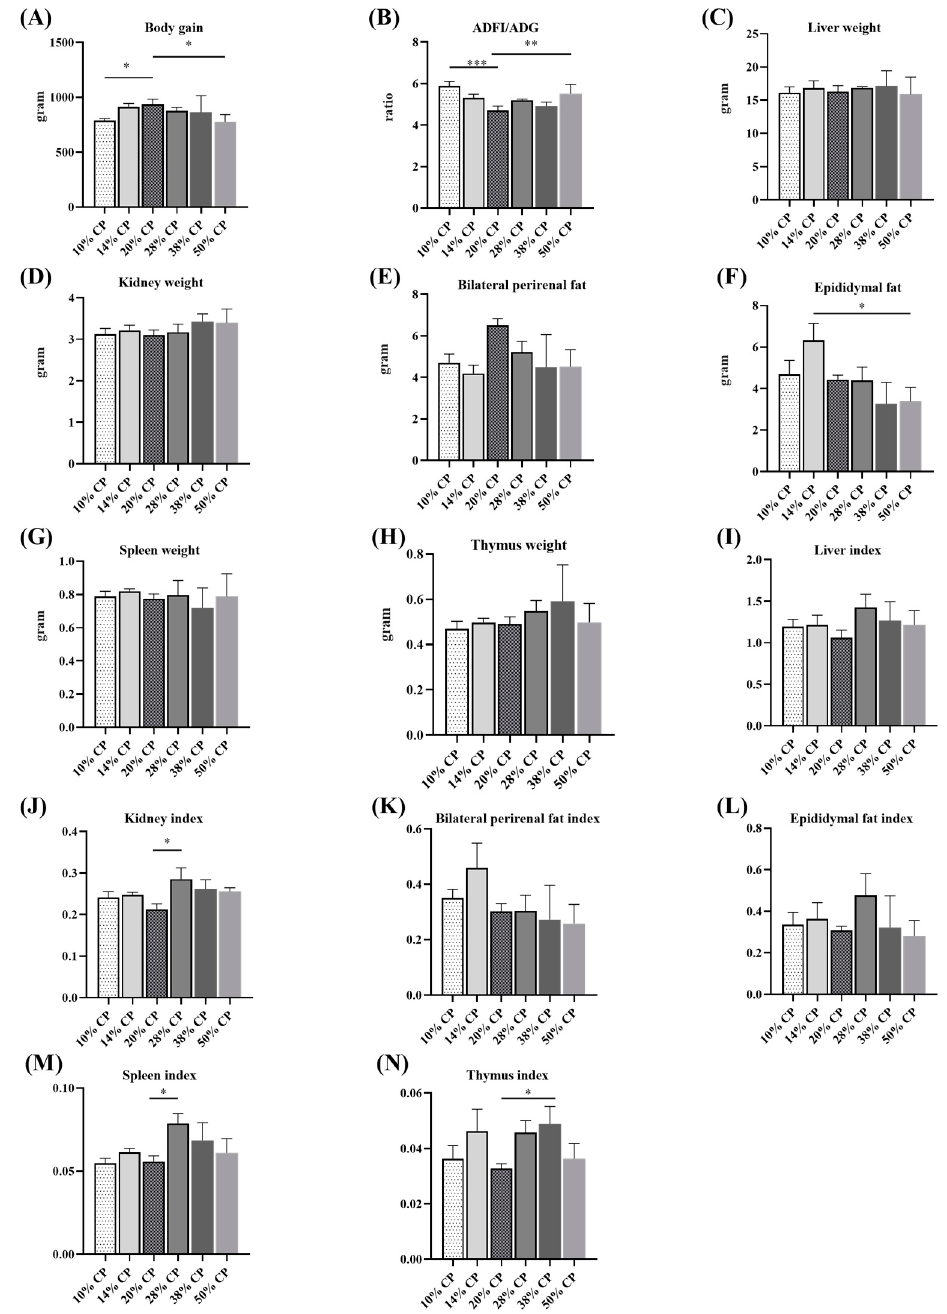
Figure 1. E ff ects of feeding diets with di ff erent protein contents for 6 weeks on body weight gain ( A ), feed-to-gain ratio (ADFI/ADG) ( B ), liver weight ( C ), kidney weight ( D ), bilateral perirenal fat weight ( E ), epididymal fat weight ( F ), thymus weight ( G ), spleen weight ( H ), and the ratios of liver ( I ), kidney ( J ), bilateral perirenal fat ( K ), epididymal fat ( L ), thymus ( M ), and spleen ( N ) relative to the body weight ( n = 6). * p < 0.05, ** p < 0.01, and *** p < 0.001, compared with the 20% crude protein